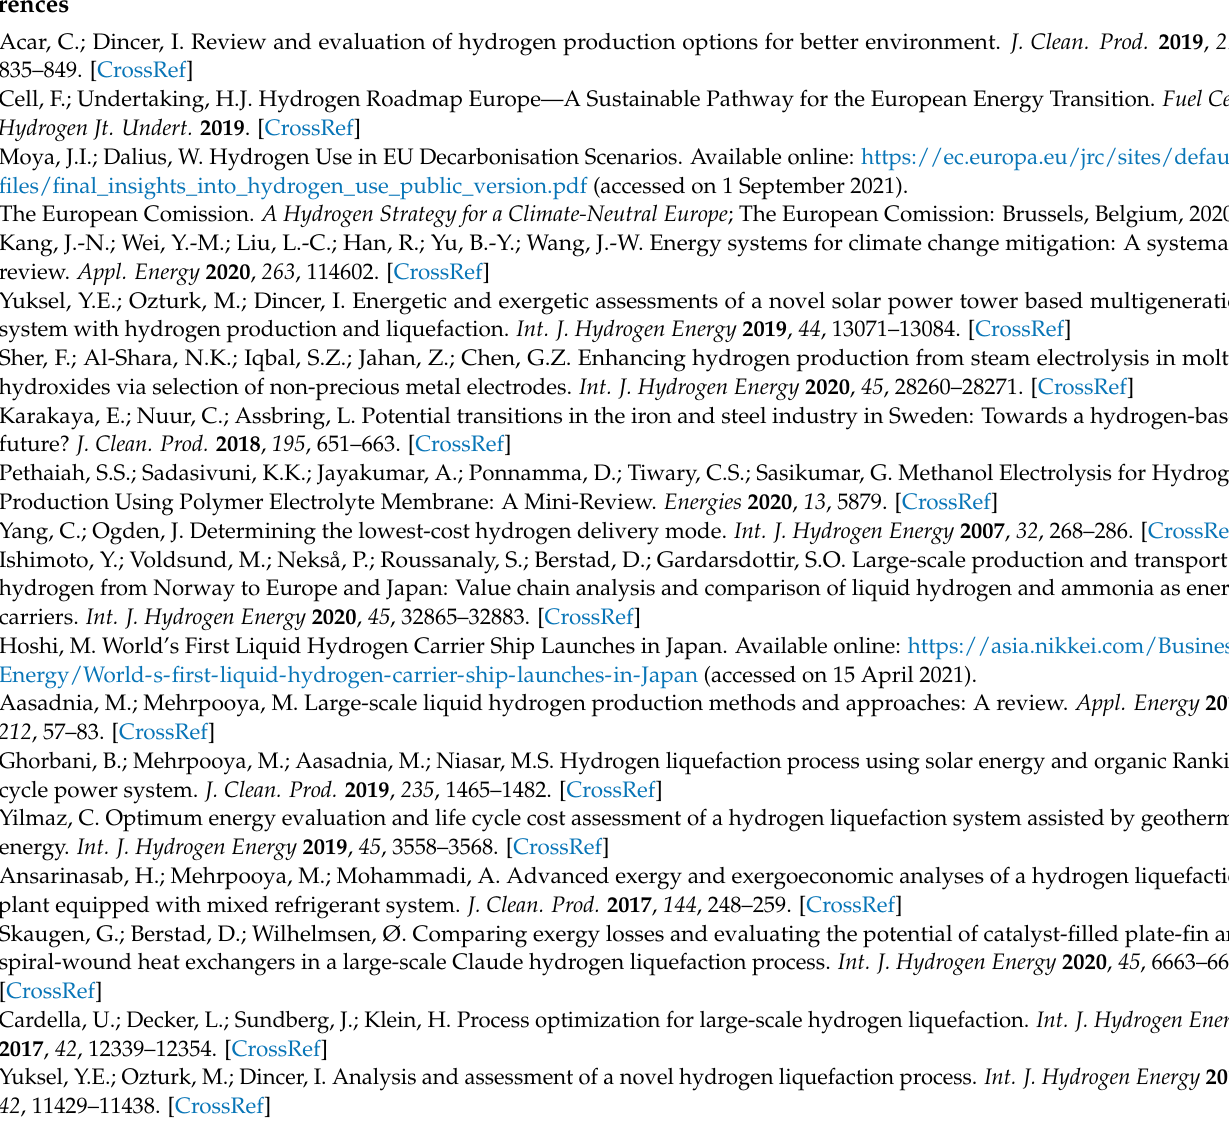
Figure A9. Optimized composite cooling curves for 45°C cooling temperature.